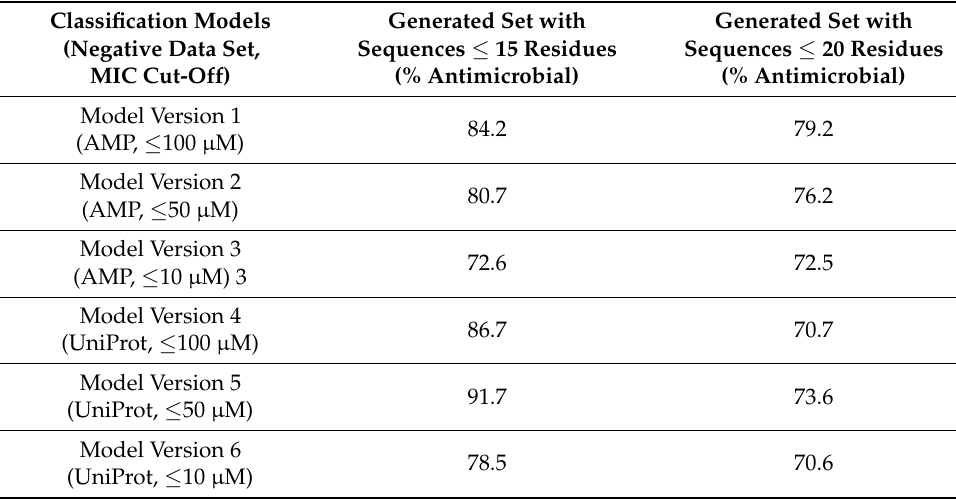
Table 2. Predictions of newly generated AMP sets by each classification model.